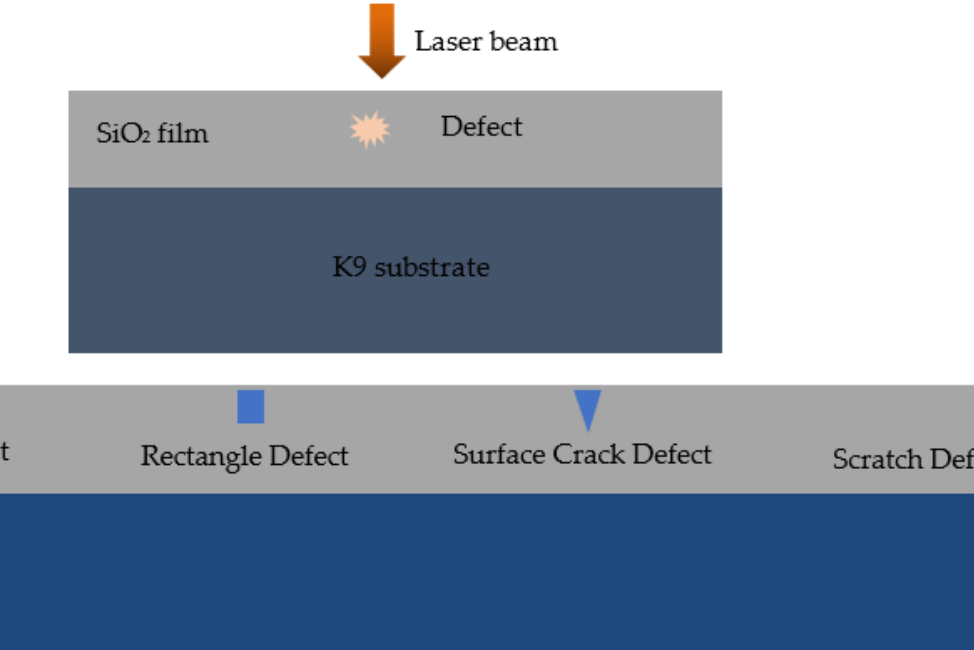
Figure 1. Schematic diagram of SiO 2 film containing defects with different geometries irradiated by a laser.